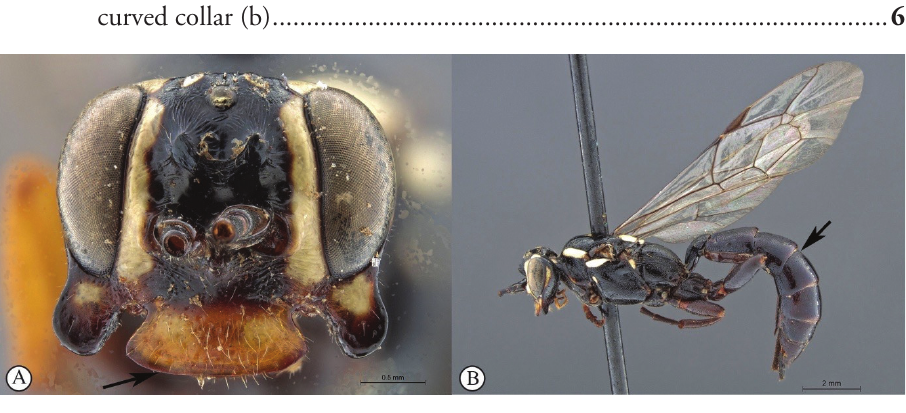
– Lower gena not expanded (a), or distinctly less expanded into a backward